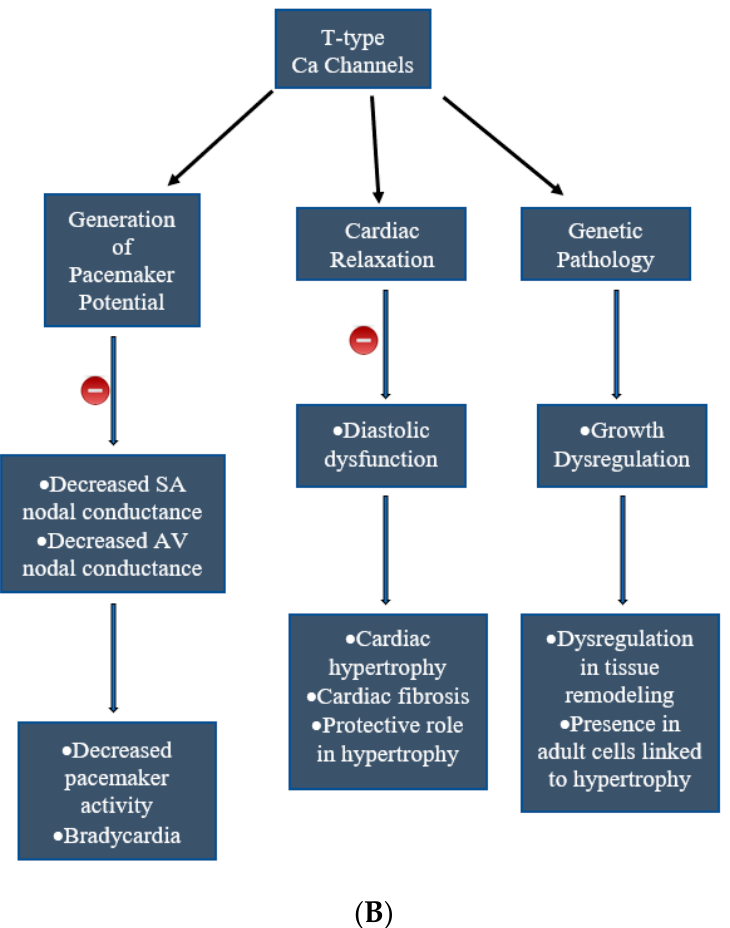
Figure 2. Charts represent the types of calcium channels in the heart, their function and the dysfunctions they are associated with. ( A ). L-Type channels, ( B ). T-type channels.